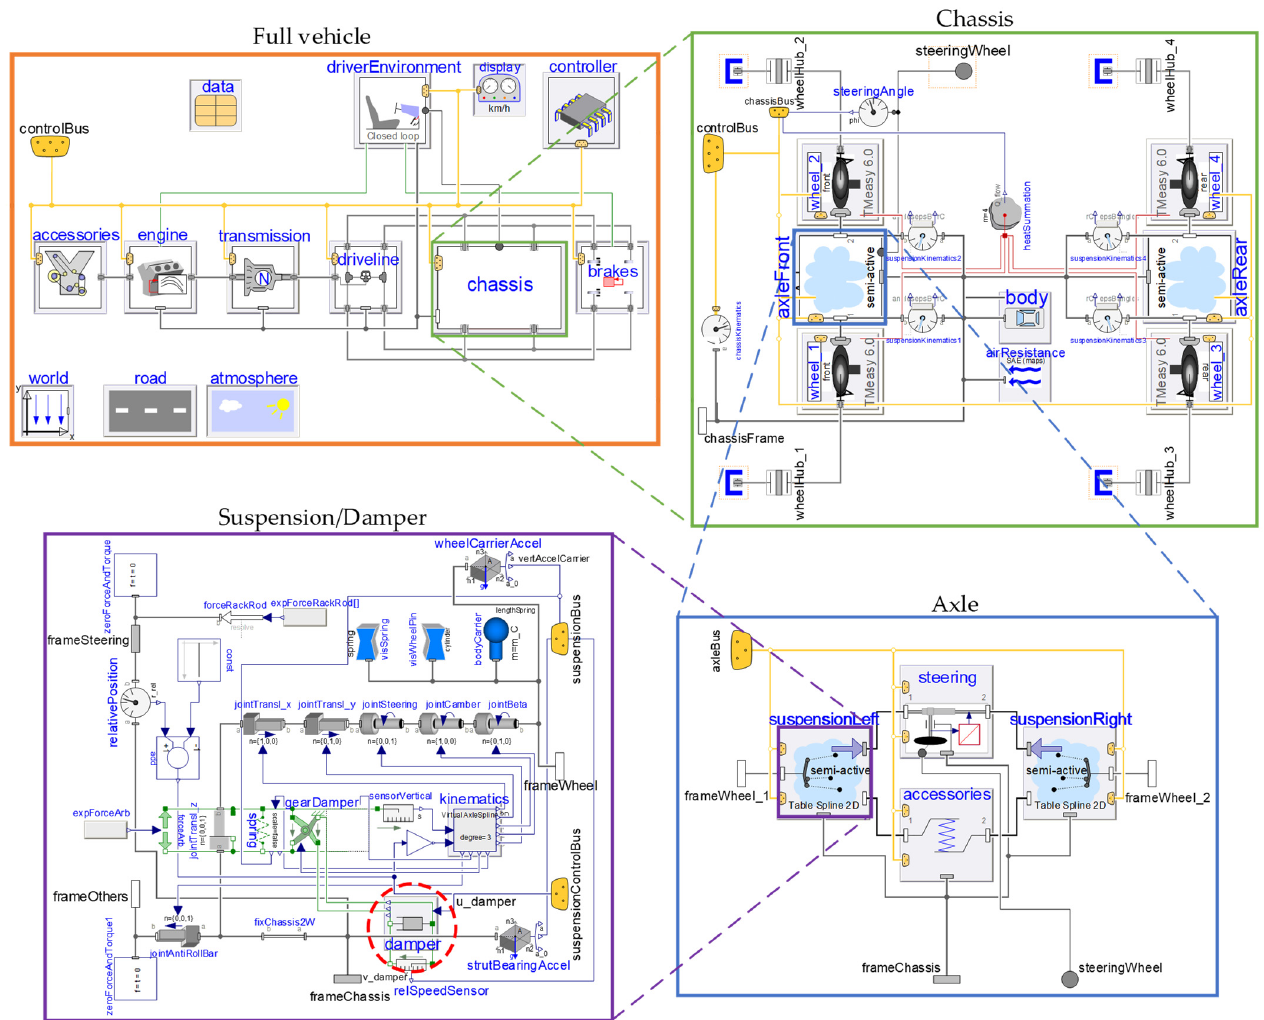
Figure 4. Overview of the full vehicle model and its various submodels in Modelica. The semi-active damper model is encircled.